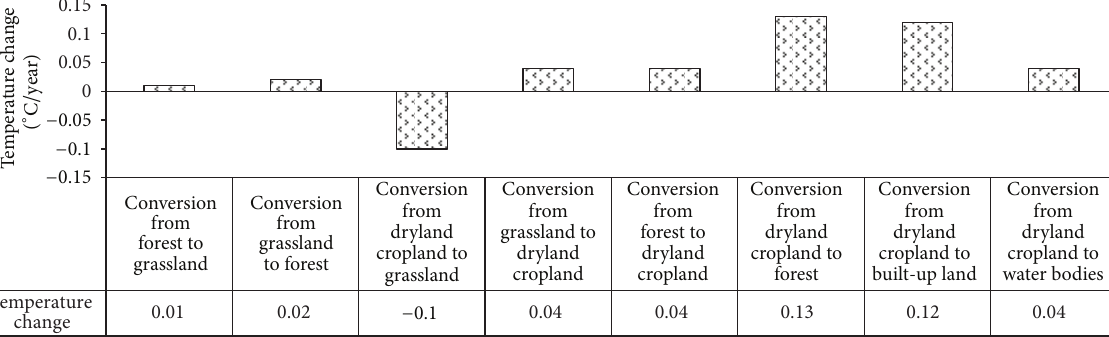
Figure 10: Change of the near-surface temperature corresponding to each type of land cover